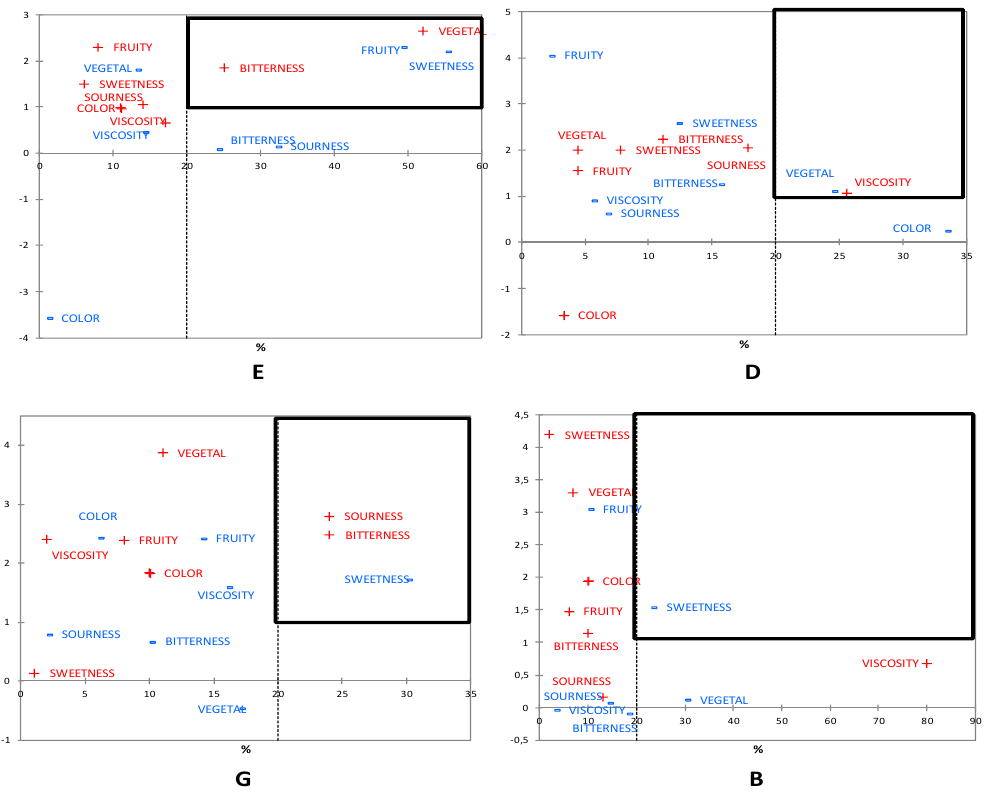
Figure 2. Penalty analysis of attribute intensity assessed by consumers of selected commercial smoothies (sample code indicated on the top right of each figure; “too low intensity” is indicated by the symbol “ − ”, and “too high intensity” is indicated by the symbol “+”).